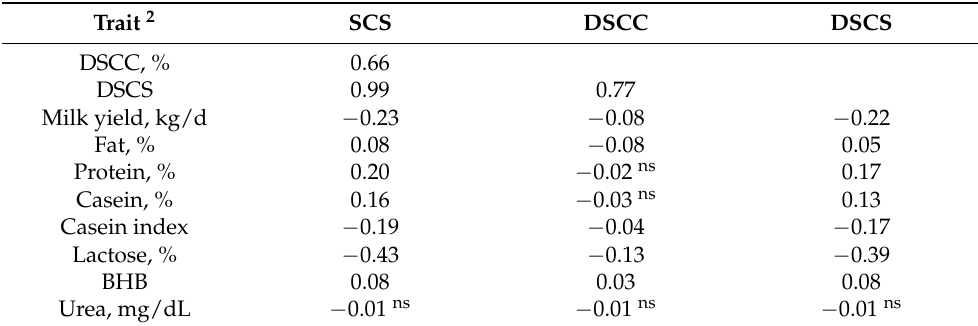
Table 2. Pearson’s correlations 1 ( p ≤ 0.05) between milk yield and composition traits 2 . Trait 2